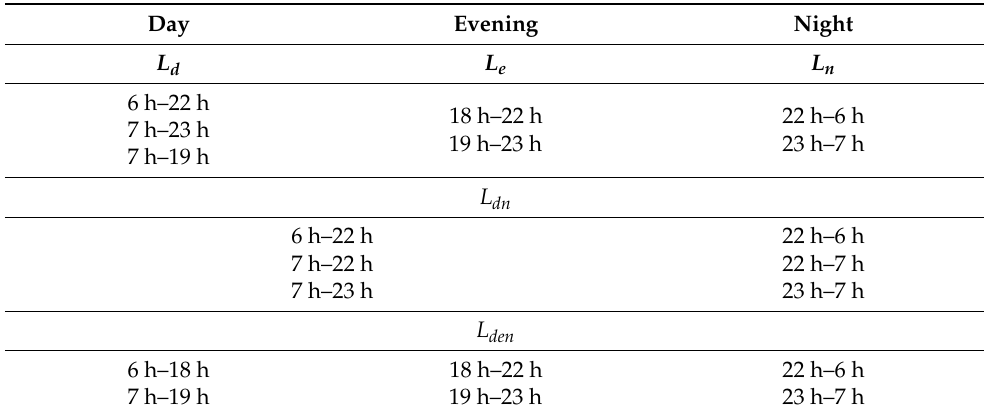
Table 4. Applicable measurement periods for Brink’s